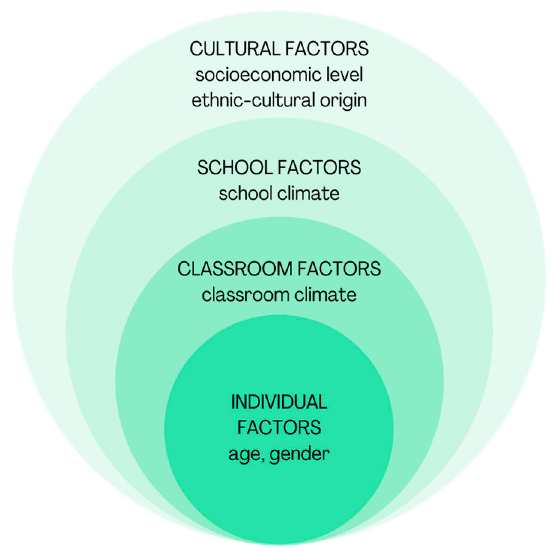
Figure 2. Levels of school violence. Source: López et al. [28].